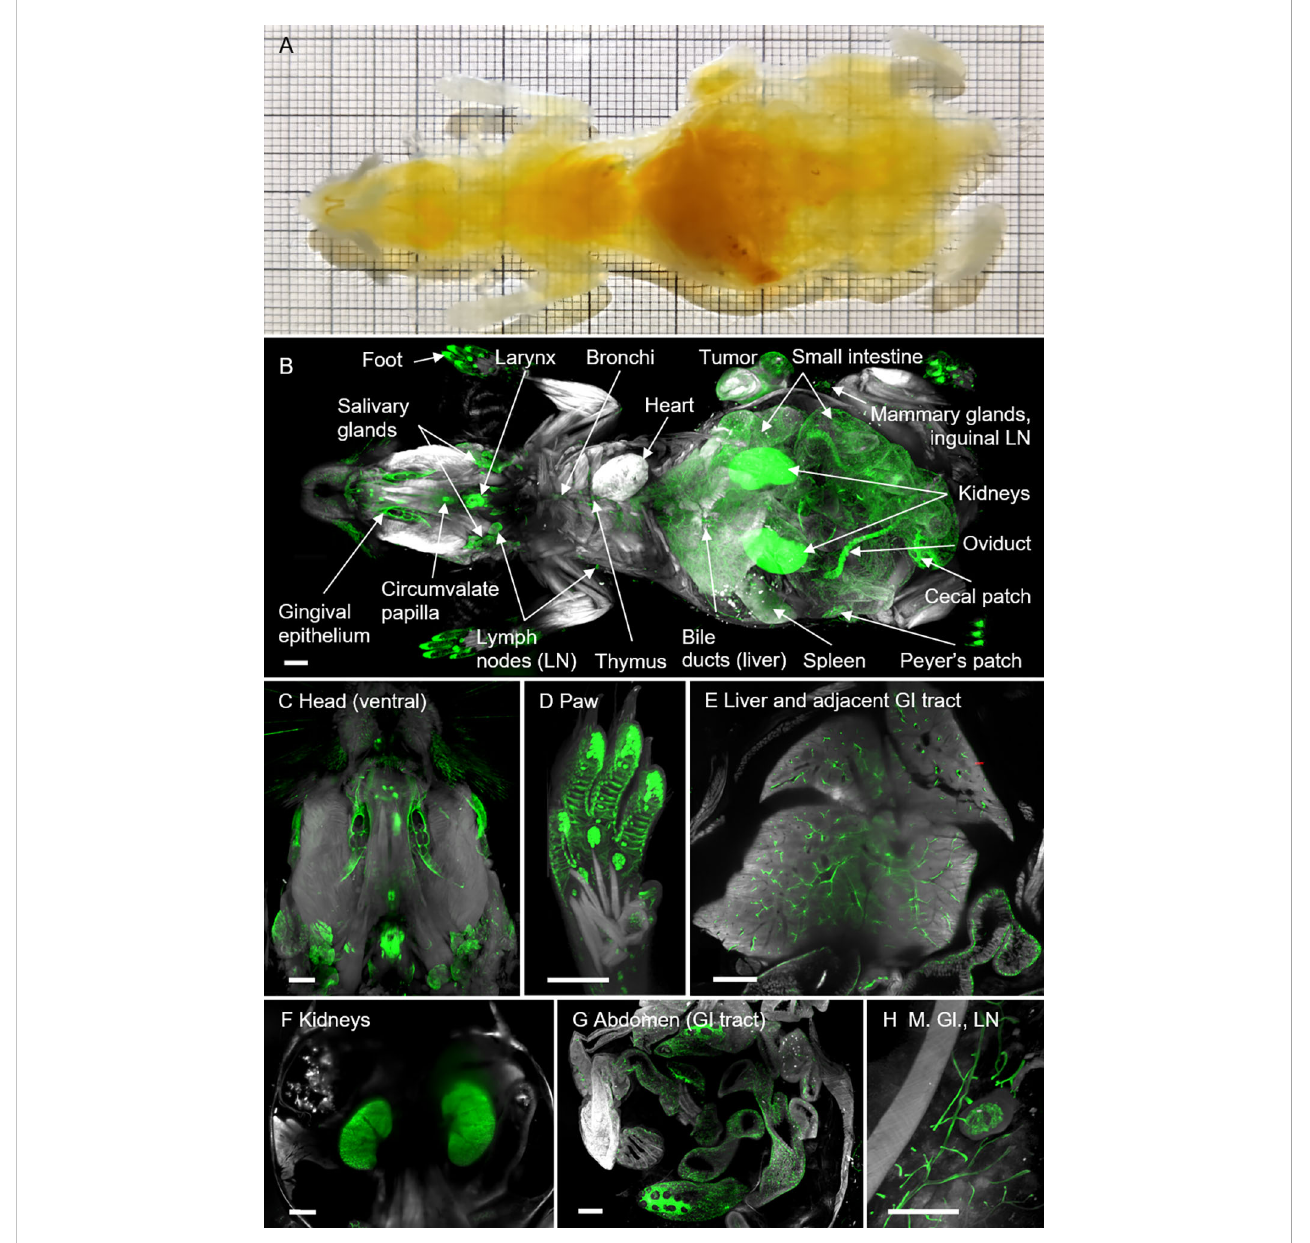
FIGURE 3 Entire mouse body cleared using the ROCKETS whole-mouse procedure and LSFM imaging reveals holistic biodistribution of anti-EpCAM antibody (G8.8R). (A) Mouse body (ventral view) after decalci fi cation, preclearing, dehydration and immersion in BABB shows excellent transparency. Thick squares of the grid = 1 cm. (B) LSFM rendering of the tissue ’ s auto fl uorescence (grey) and anti-EpCAM staining (G8.8R in green) as overlay enabled quick localization of antibody disposition and identi fi cation of positive tissues. (C-H) LSFM renderings (ventral views) of EpCAM + tissues (G8.8R in green) in situ . M. Gl. = Mammary glands, LN = Lymph node. Scale bars = 2